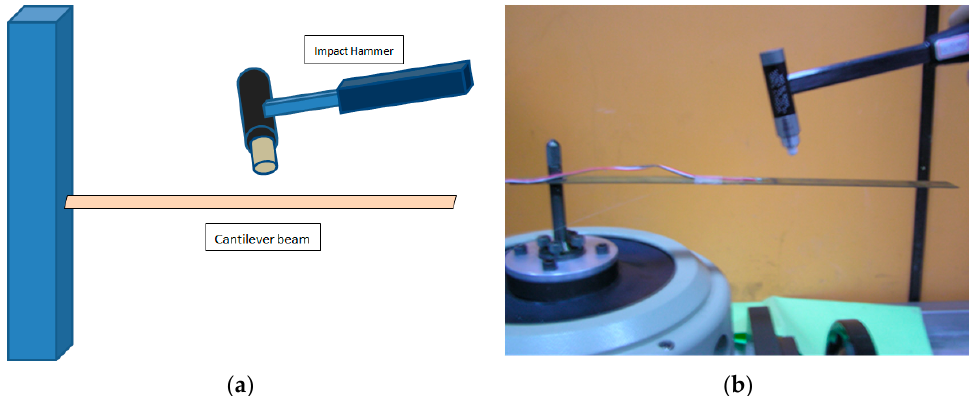
Figure 11. Cantilever beam impacted by a hammer. ( a ) schematic diagram; ( b ) experimental setup. Appl. Sci. 2019 , 9 , x FOR PEER REVIEW